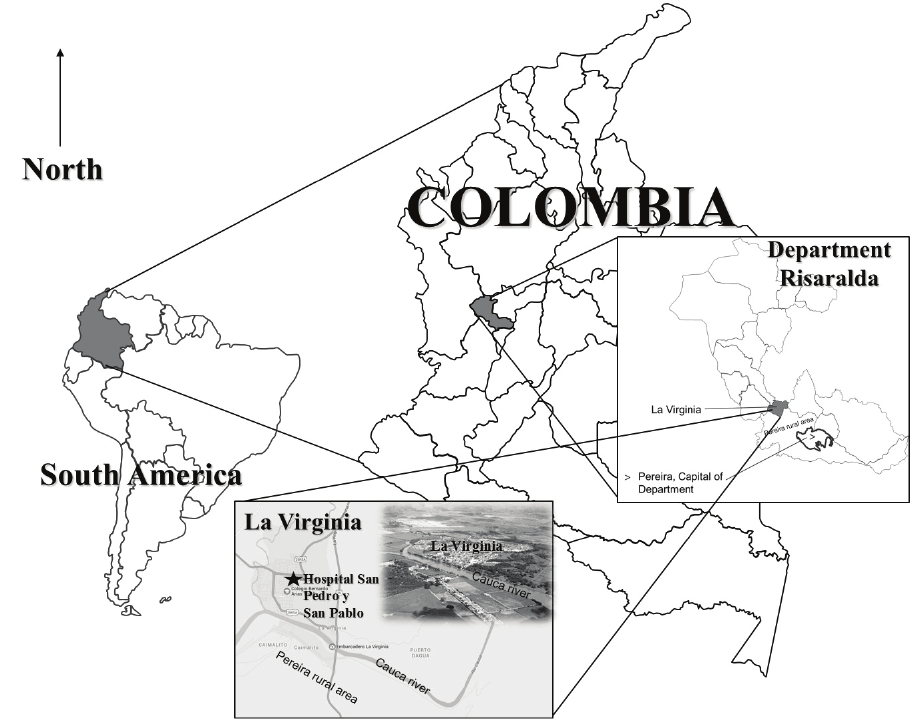
Figure 1. Study area, La Virginia city/municipality, Risaralda department, Colombia, South